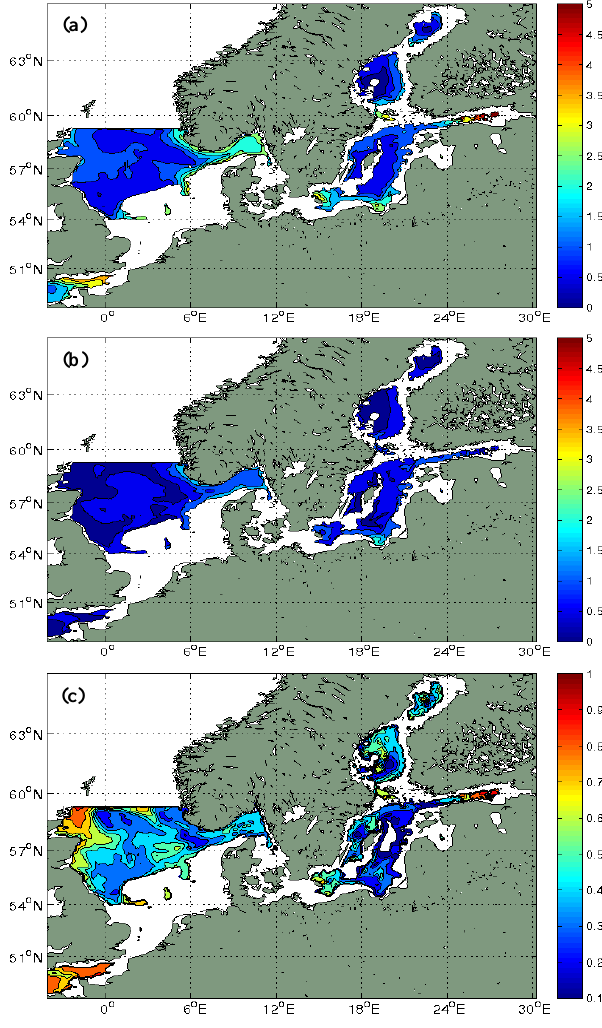
Figure 3, Similar to figure 2, but at the depth of 75 m. Fig. 3. Similar to Fig. 2, but at the depth of